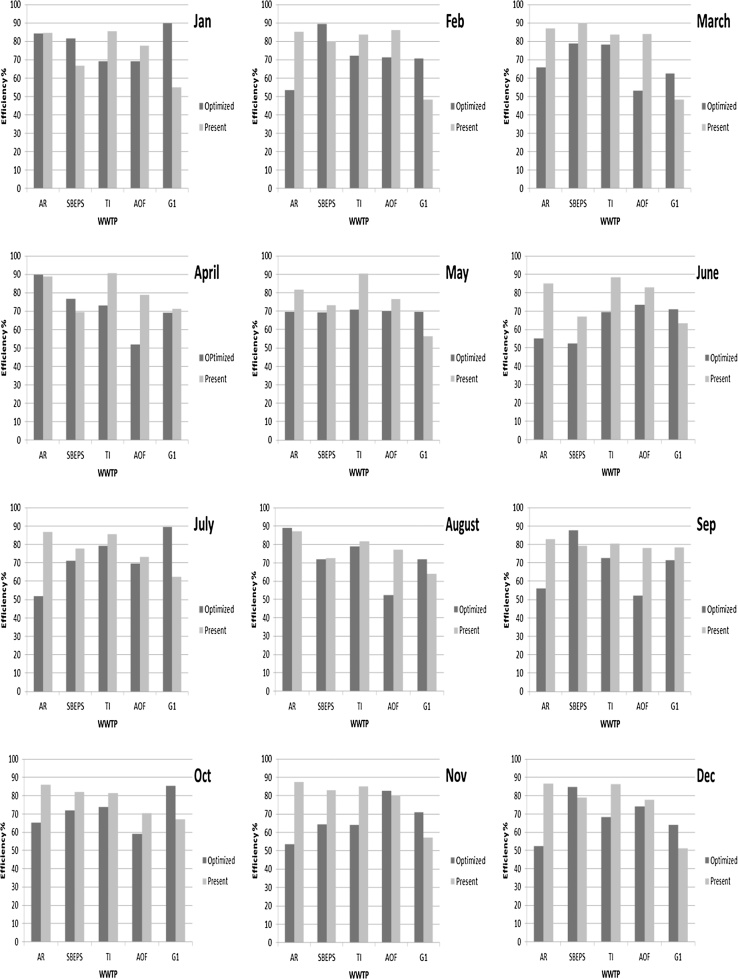
Optimized and present efficiency of five WWTPs for each month in 2016.